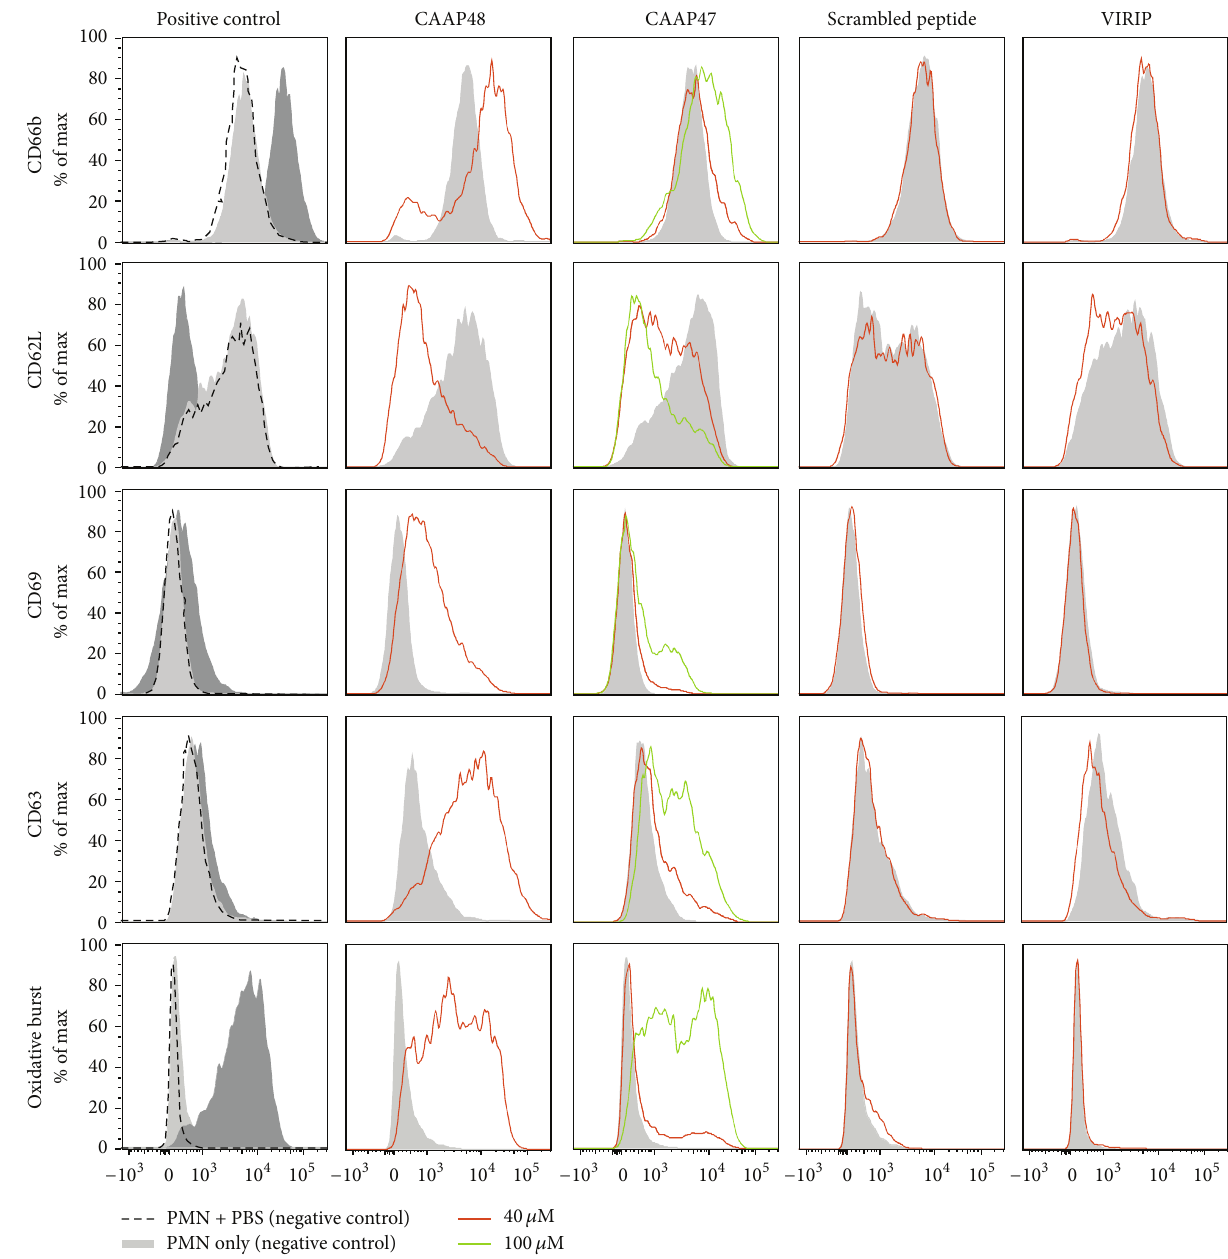
Figure 1: Incubation of neutrophil granulocytes (PMN) with CAAP48 results in cellular activation. PMN activation is shown 30min after incubation with CAAP48 and the other AAT peptides by changes in the surface expression levels of activation/degranulation markers CD66b, CD63, CD69, and CD62L. Oxidative Burst was determined by detection of intracellular generated reactive oxygen species (oxidation of dihydrorhodamine-123 to rhodamine-123, R-123). Data obtained by using 40 𝜇 M and 100 𝜇 M peptide concentrations of one exemplary experiment out of four independent experiments are shown. Phorbol myristate acetate (PMA) was used as positive control and 1x PBS diluted in RPMI 1640 (1: 2) as well as PMN in RPMI 1640 without PBS served as negative control.